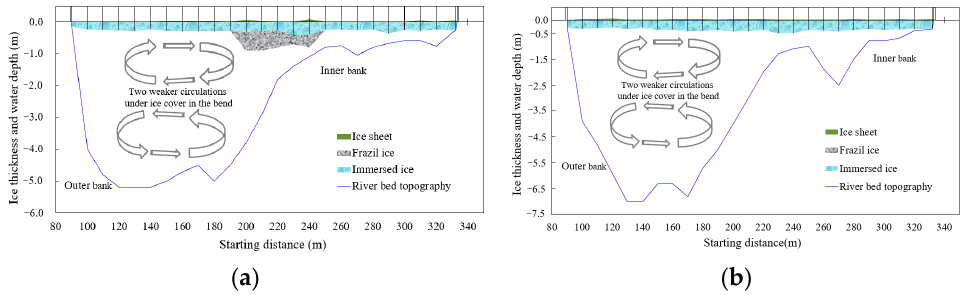
Figure 7. The distribution of water depth and ice condition of the Shensifenzi bend in ( a ) 18 December 2014 and ( b ) 2 January 2015.